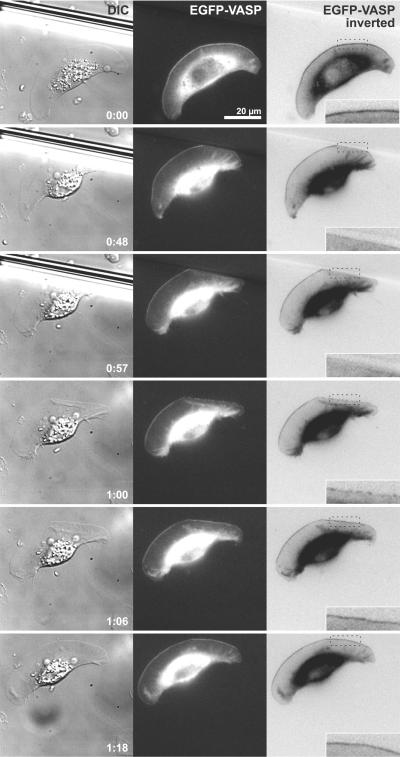
Nascent Lamellipodia Emerge with Rough Edges Accumulating VASP in Microprotrusions Eventually Maturing into a Smooth MorphologyWe developed a method to generate nascent lamellipodia during recovery of protrusion after temporarily stalling a section of the lamellipodium. A glass micropipette, acting as a barrier, was lowered into the path of movement of a migrating keratocyte overexpressing EGFP-VASP and forced down until a section flexed parallel to the surface. The pipette was left in place until the cell was in firm contact with the pipette and subsequently removed by translating the pipette in the direction of cell migration. A coherent keratocyte shows EGFP-VASP as a uniform thin line at the leading (time: 0:00, min:s). Fluorescent images are shown in both regular and inverted contrast for clarity. Insets show inversed and zoomed in images of the corresponding boxed areas of the leading edge. When this keratocyte reaches the edge of the barrier, the lamellipodium temporarily stops protruding forward and acquires a very flat shape corresponding to the shape of the barrier (time: 0:48, 0:57). The cell continues migrating in the original direction of motion while EGFP-VASP becomes displaced from the edge of the region in contact with the barrier (see inset). When the micropipette barrier is removed (between 0:57 and 1:00), the leading edge of the lamellipodium immediately resumes protrusion and appears rough with several protruding microregions enriched in EGFP-VASP (time: 1:00). The levels of EGFP-VASP quickly recover along the impacted region and become uniform (time: 1:06). Only 18 s after removal of the barrier, the keratocyte's original shape and EGFP-VASP localization at the leading edge are restored (time: 1:18). Scale bar = 20 μm.